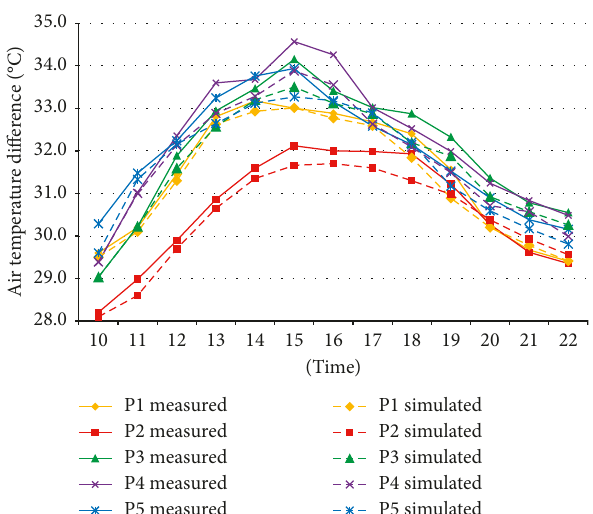
Figure 4: Comparison between simulated and measured air